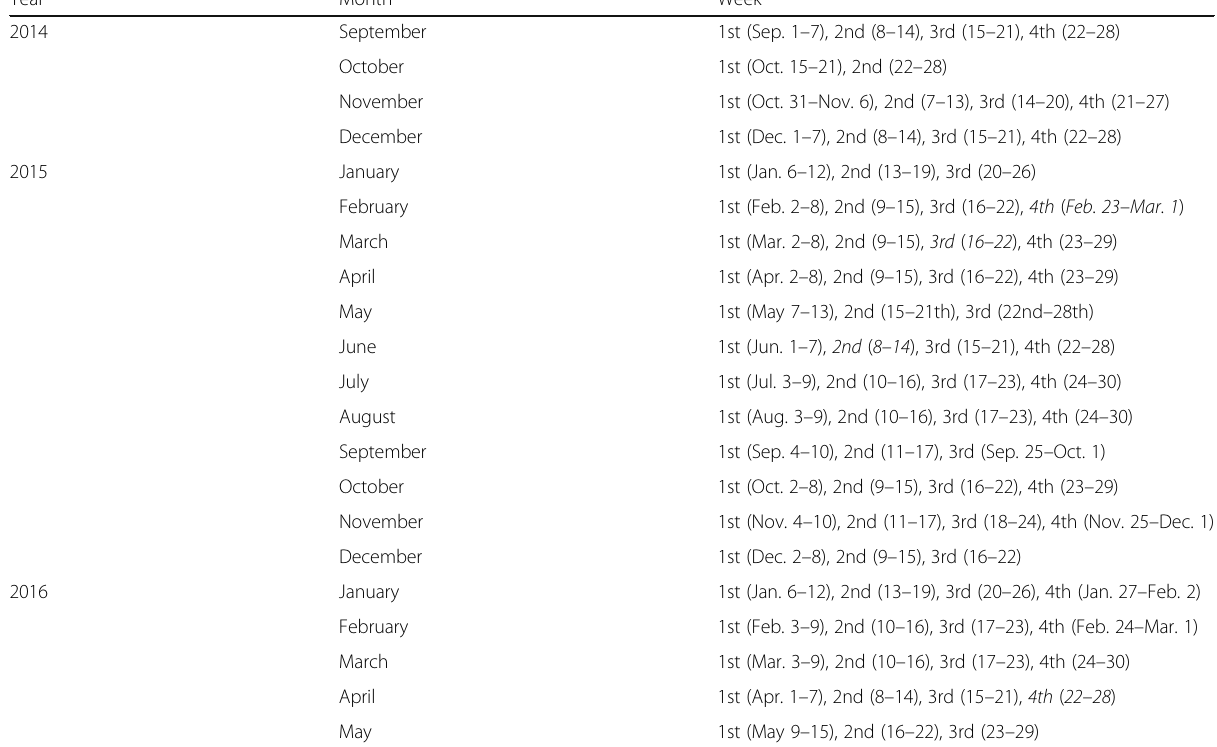
Table 1 Sampling periods of the